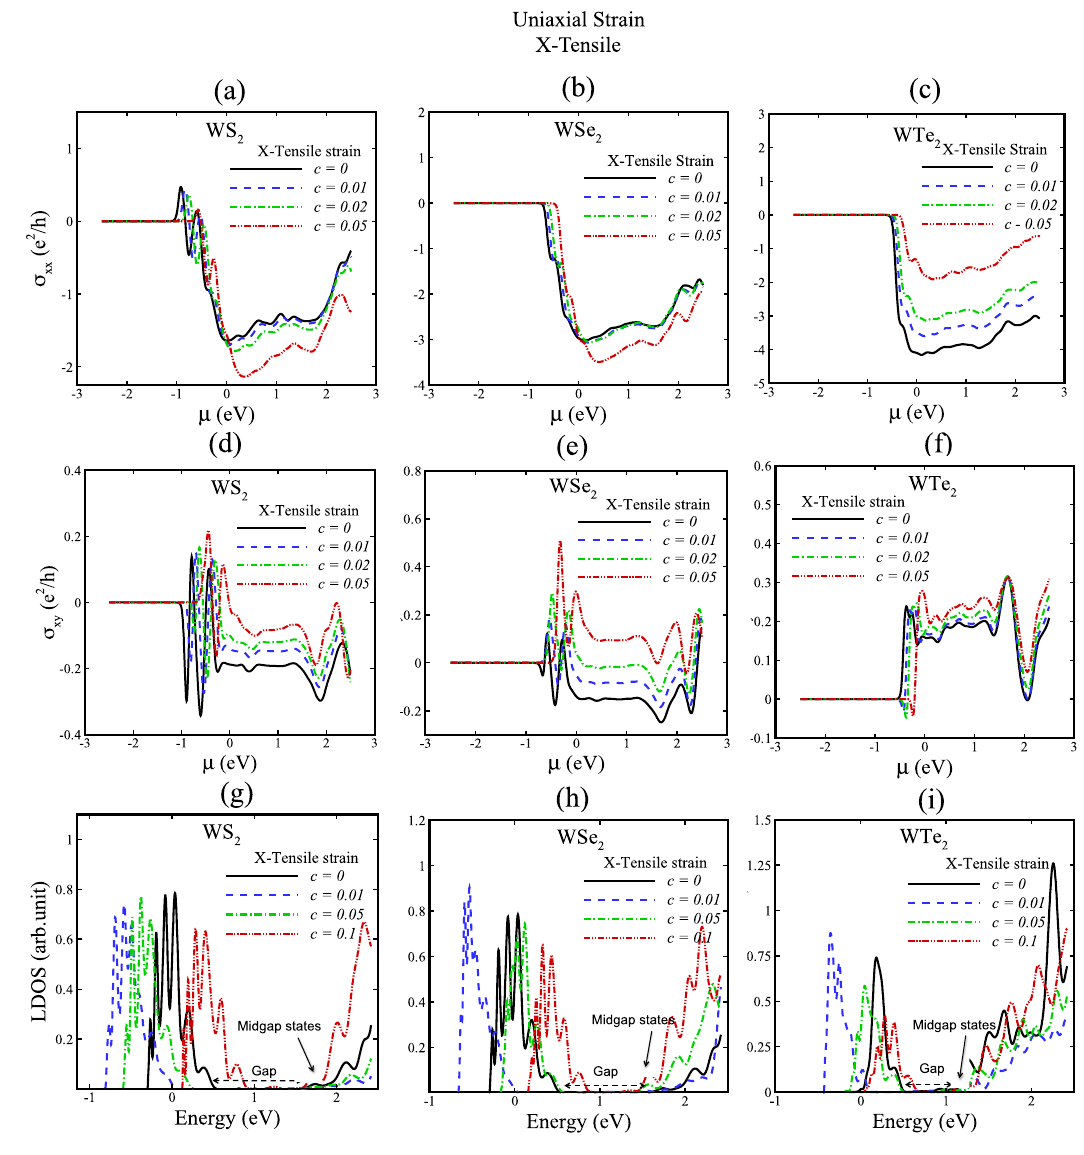
Figure 7. Hall conductivity and local density of states (LDOS) of WX 2 (X = S, Se, Te) for uniaxial X-tensile strain with c = 0, 0.01, 0.02, 0.05, 0.1. In ( g ), ( h ) and ( i ) gap and midgap states are